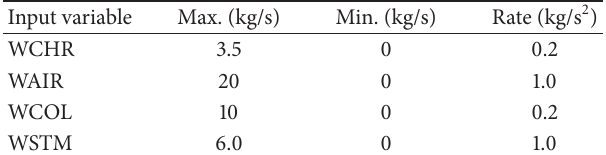
Table 2: Input limits.